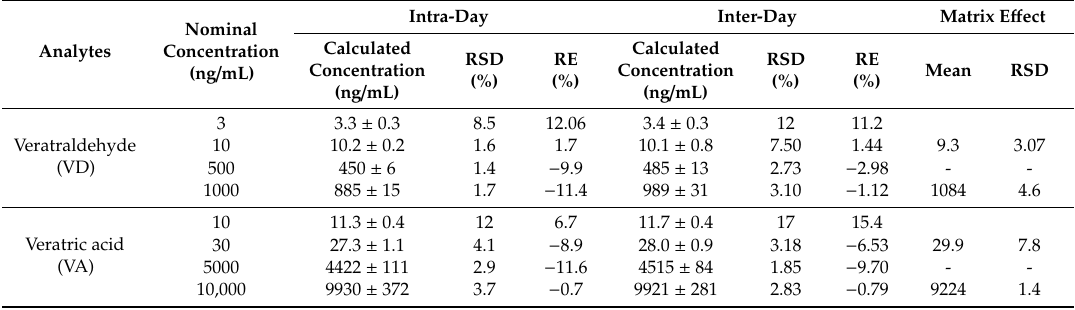
Table 3. The intra-day and inter-day precision, accuracy, and matrix effect for two analytes in rat plasma. RE, relative error.